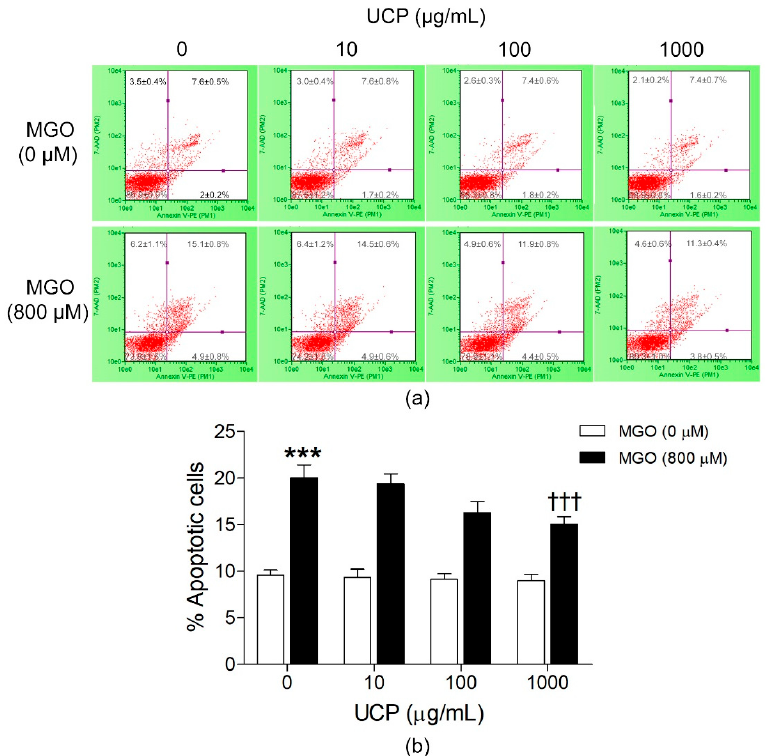
Figure 2. Effects of UCP on MGO-induced cell apoptosis. Apoptotic cells were determined by An- nexin V-PE and 7-AAD probe and analyzed by a flow cytometer. ( a ) Dot plot diagrams